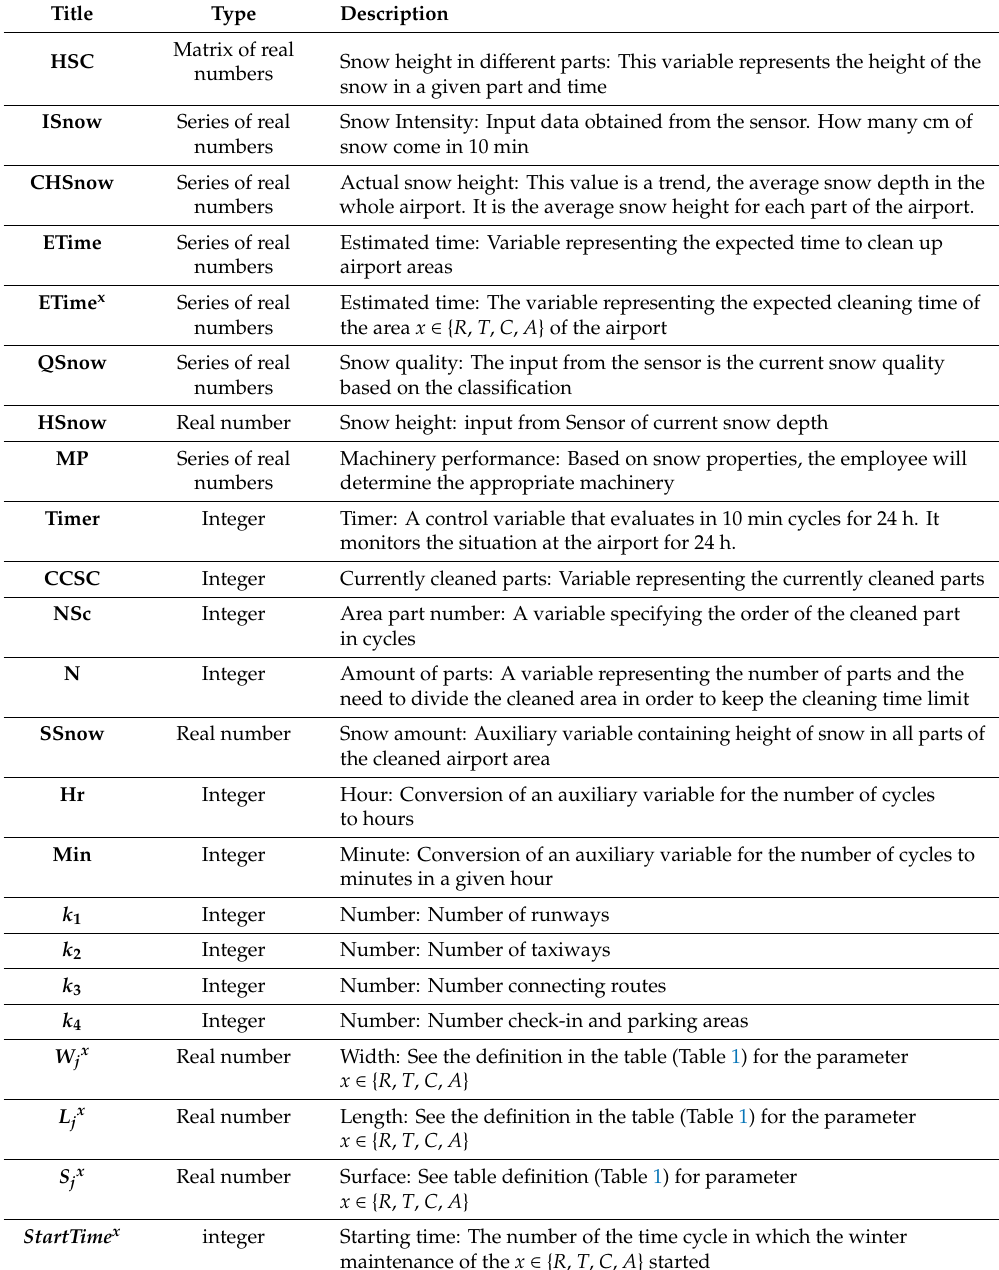
Table 3. All inputs, parameters, variables, and their description.